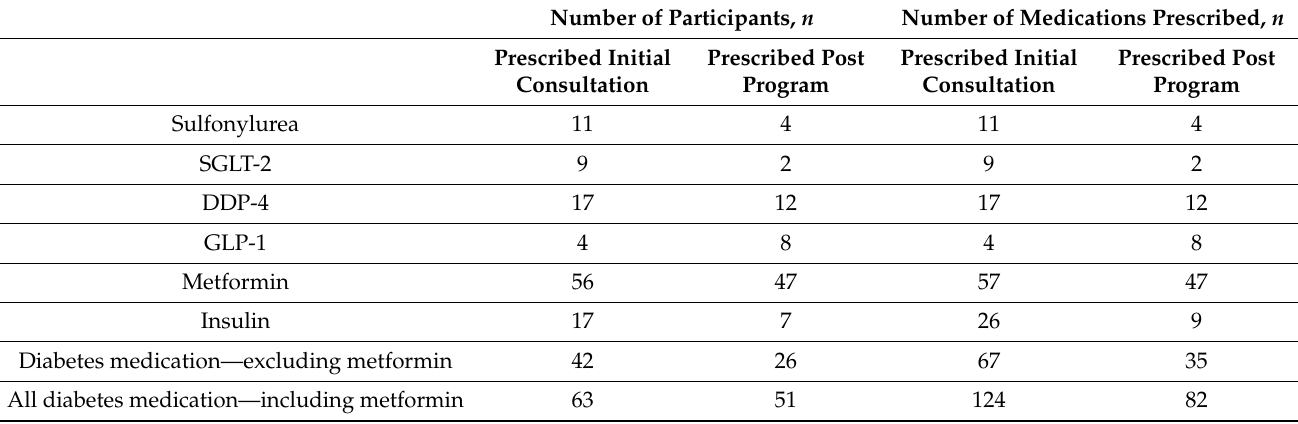
Table 4. Frequency of participants prescribed diabetes mediation and diabetes medications prescribed at comment and following program